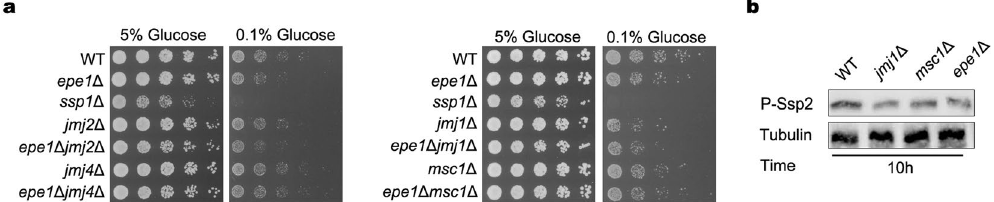
Figure 4. Jmj1 and Msc1 contribute to phosphorylation of Ssp2 and activation of AMPK pathway. ( a ) Growth of WT, jmj2 Δ , jmj2 Δ epe1 Δ , jmj4 Δ , jmj4 Δ epe1 Δ , jmj1 Δ , jmj1 Δ epe1 Δ , msc1 Δ and msc1 Δ epe1 Δ cells on low- glucose solid medium in serial dilution assays. ( b ) Western blot to examine amount of P-Ssp2 in WT, jmj1 Δ , msc1 Δ and epe1 Δ cells after growing in YES for 10 h. Cropped blots are shown for clarity. Full-size blots are shown in Supplementary Figure